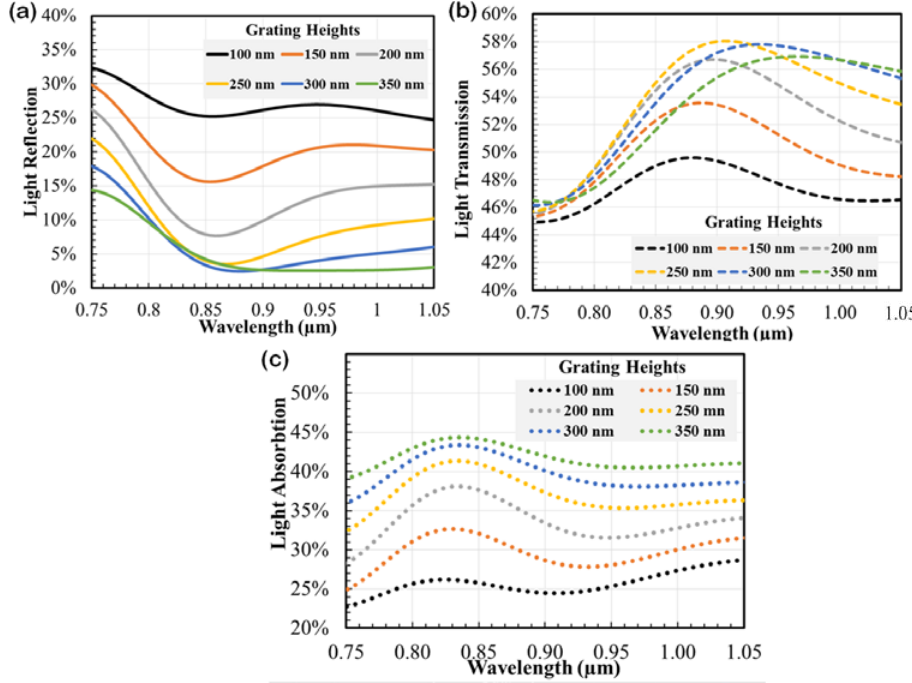
Figure 5. Observation of light reflection ( a ), transmission ( b ), and absorption ( c ) spectra for a triangular-shaped nano-grating structure with the grating pitch of 830 nm.